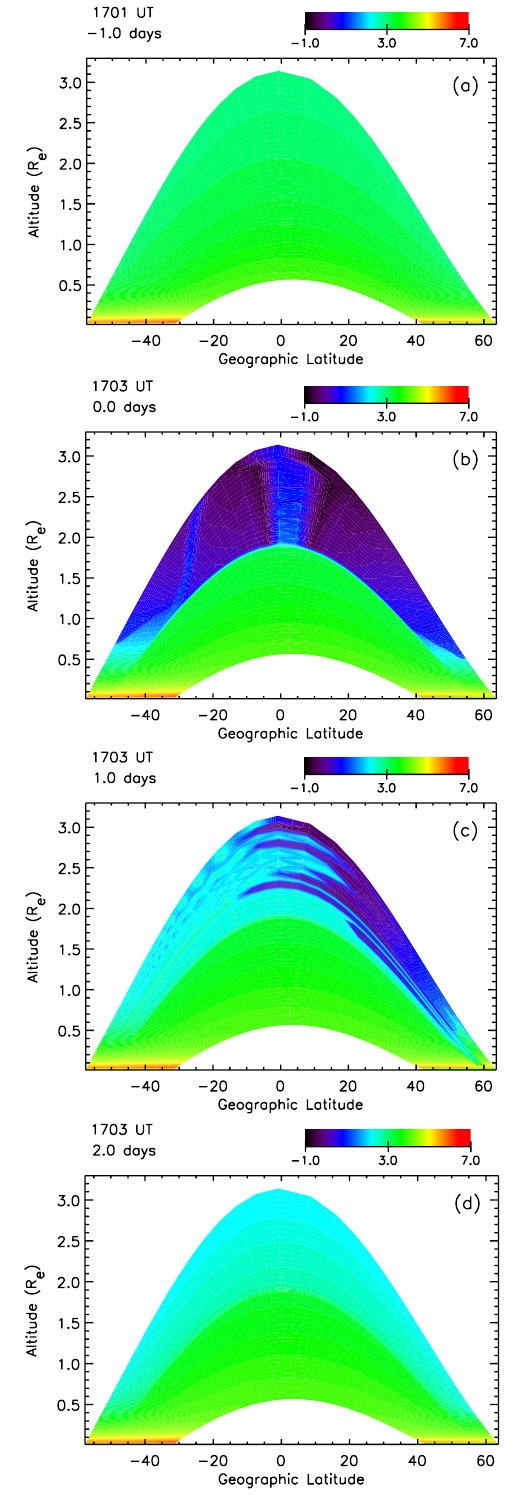
Fig. 2. Contour plots of the electron density (logarithmic) as a func- tion of latitude and altitude: (a) pre-storm, (b) post storm, (c) one day after the storm, and (d) two days after the